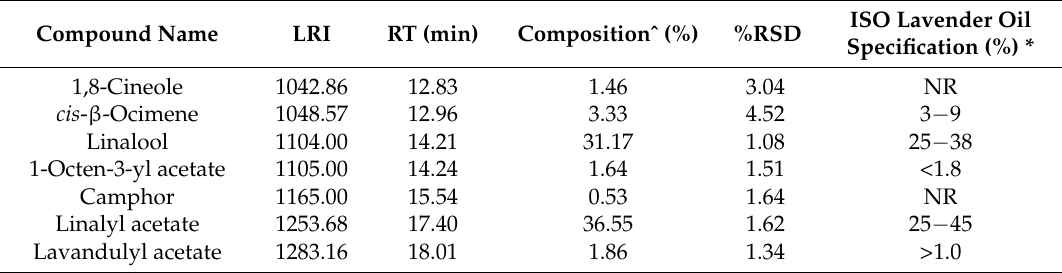
Table 1. GC-MS characteristics of reference lavender oil sample.